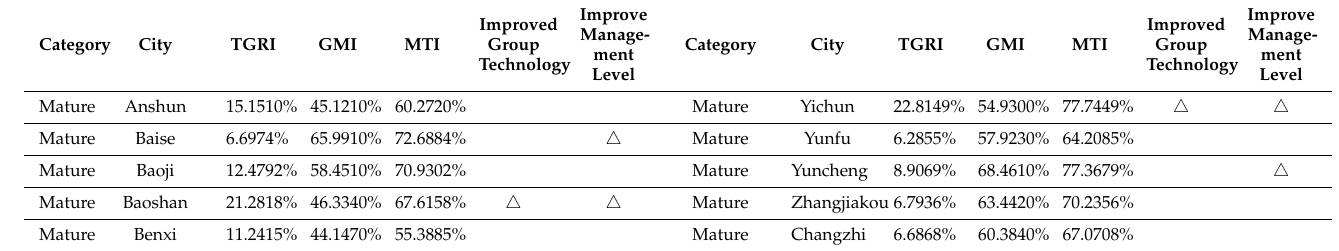
Table A2. Main paths of inefficient decomposition of high-quality input-output allocation and improvement of efficiency in mining